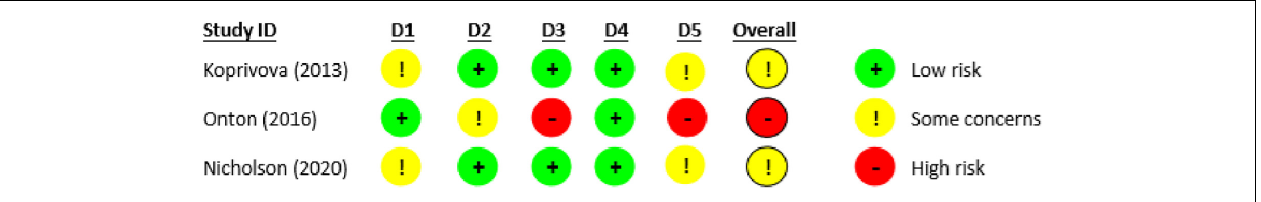
FIGURE 2 | Risk of bias in eligible studies with published/posted outcome data using version 2 of the Cochrane risk-of-bias tool for randomized trials (RoB 2.0).